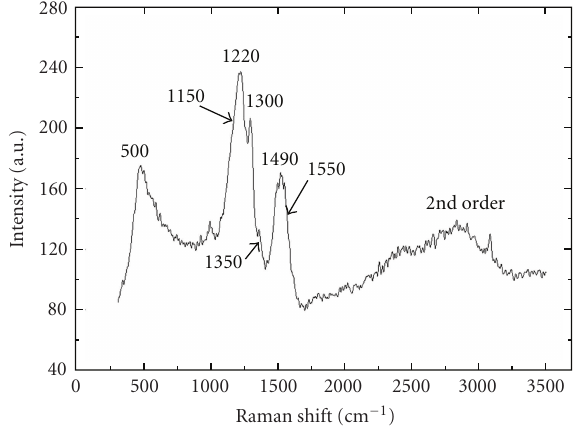
Figure 9: Raman spectrum of BDND film grown on a silicon sub- strate.